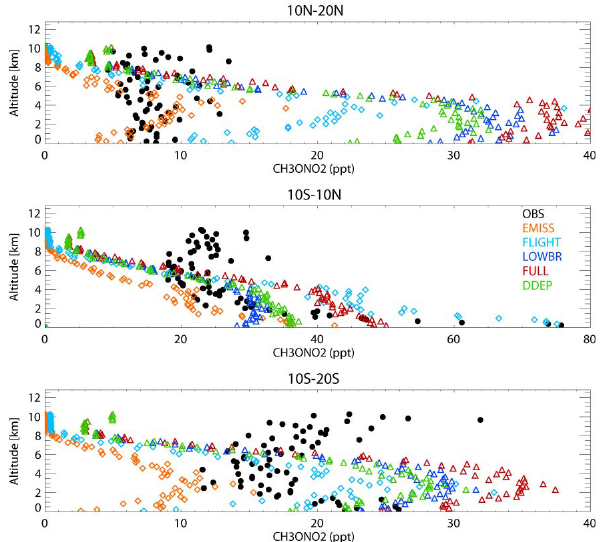
Fig. 8. A comparison of the distribution of higher alkyl nitrates as measured during March in the PEM-Tropics B measurement cam- paign and that simulated in TM5. The simulations shown are for BASE (blue) and EMISS